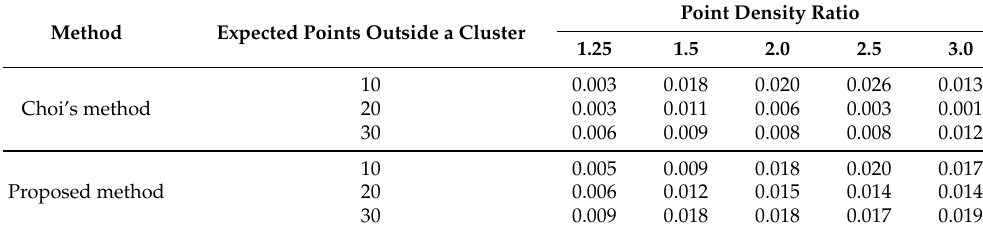
Table 4. Evaluation results for the false-positive